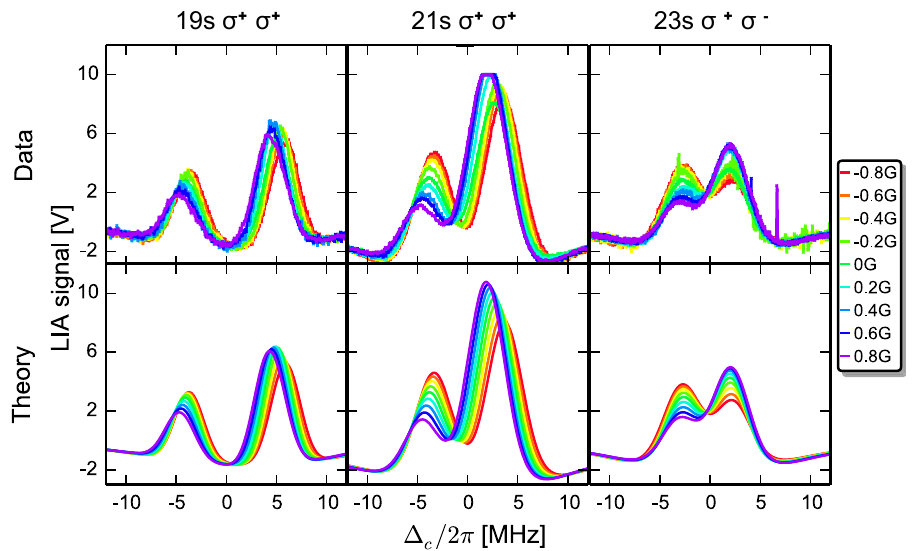
Figure 4: Measured (LIA: Lock-in amplifier signal) and simulated EIT spectra for the 19 s the 21 s and the 23 s Rydberg level and different combination of probe and coupling laser 1 / 2 1 / 2 polarization. The measured spectra are taken at nine equidistant magnetic field values in the range from − 0.8...0.8 G. The data of one Rydberg state are fitted with a single set of parameters, resulting in the theoretical spectra shown beneath the respective Rydberg state. The fitted hyperfine splittings are 9.13, 6.34, and 4.68MHz (left to right). The fitted Rabi / 2 π , Ω / 2 π ) are ( 10.7,3.8 ) MHz, ( 11.0,5.5 ) MHz, and ( 7.3,4.0 ) MHz. frequencies ( Ω p c